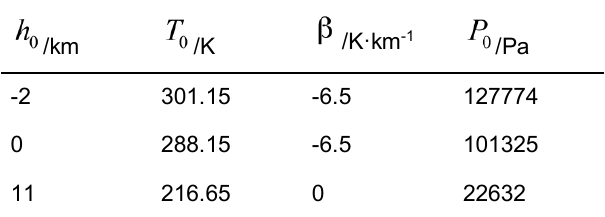
Table 1. Altitude calculation